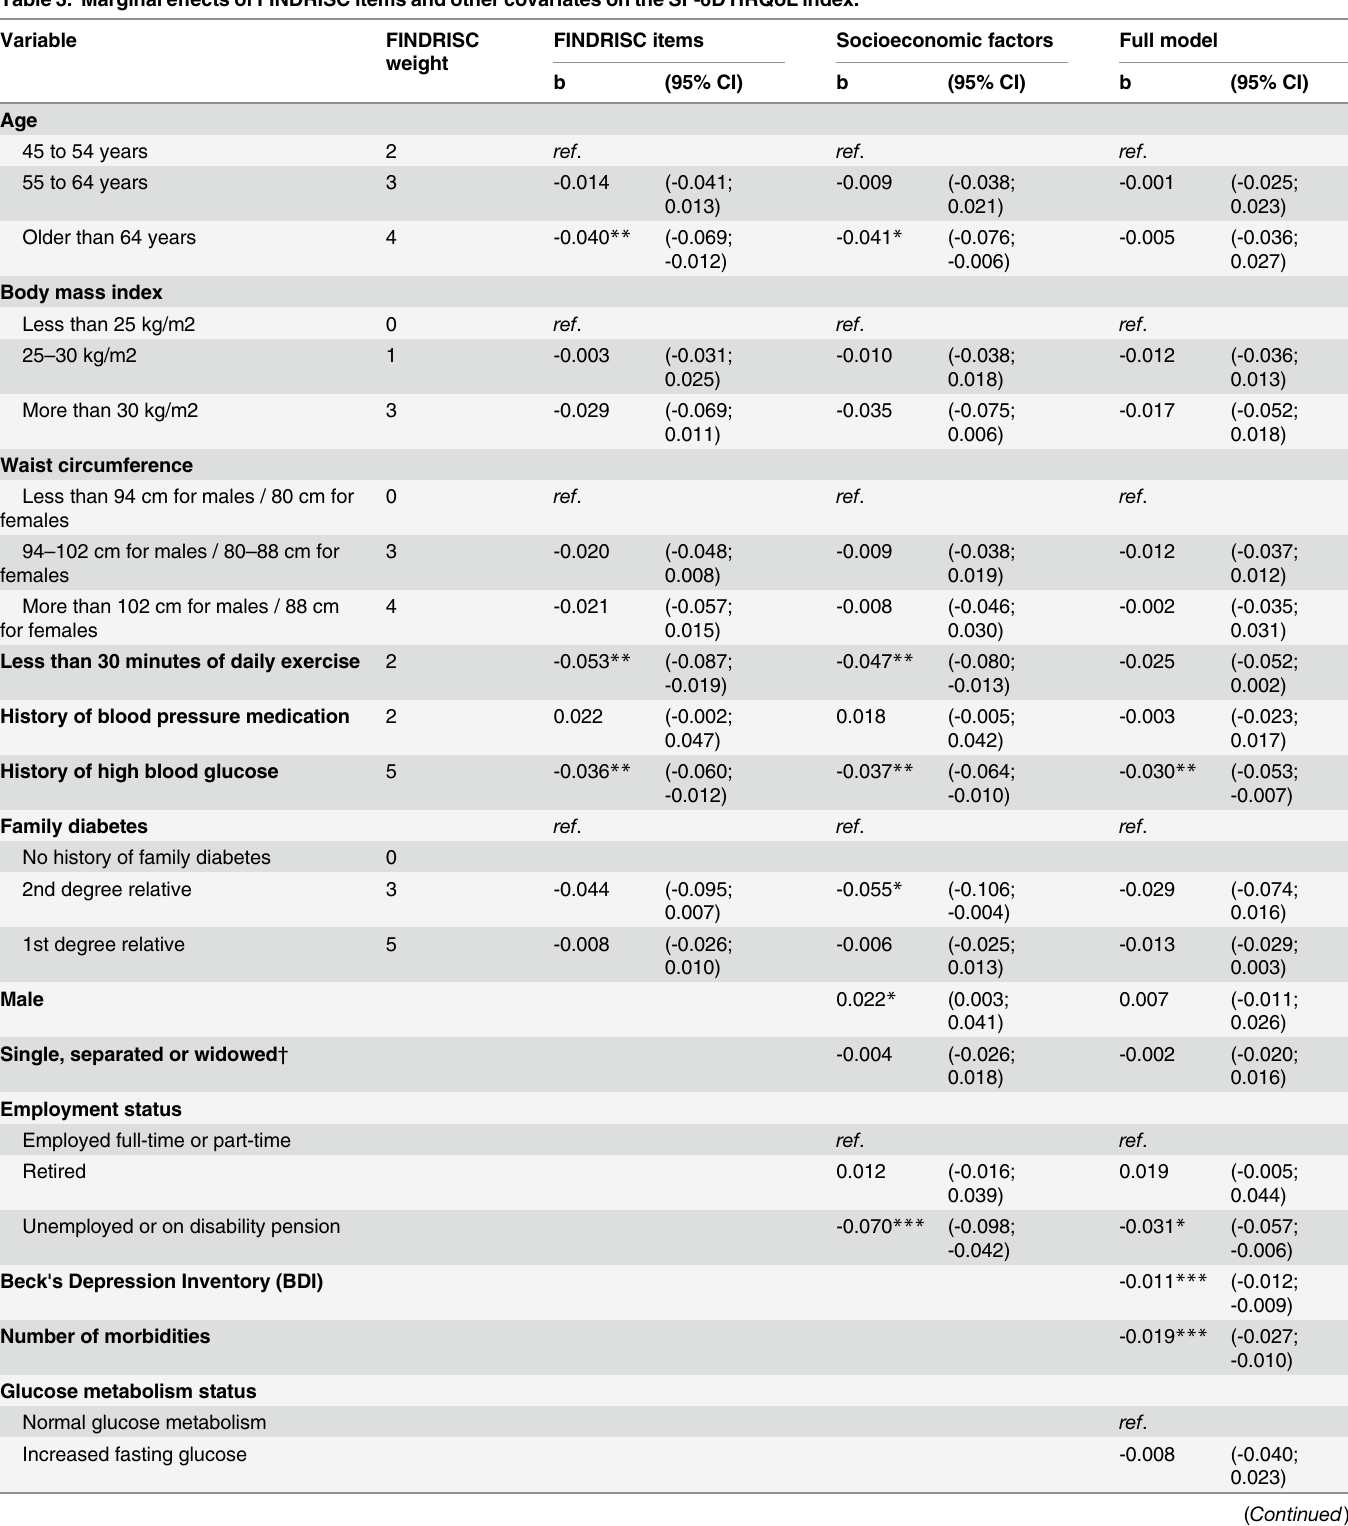
Table 3. Marginal effects of FINDRISC items and other covariates on the SF-6D HRQoL